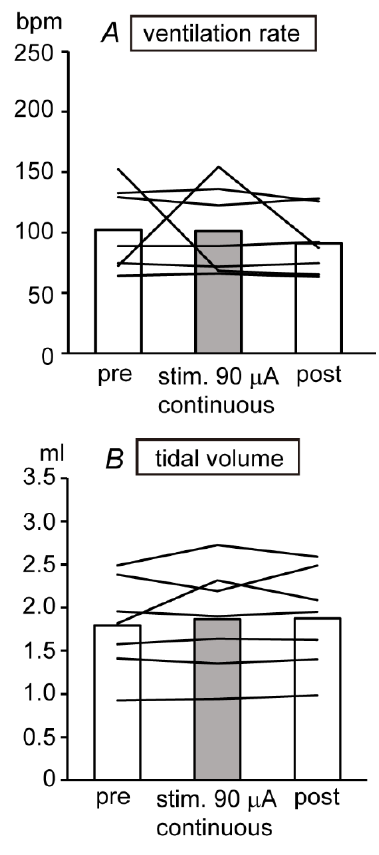
Figure 2. Effect of SLN stimulation (0.5 ms, 90 μA, continuous 40 Hz) on ventilation rate ( A ) and tidal volume ( B ) of conscious rats ( n = 7). The ventilation rate and tidal volume were averaged 30 s or 5 min before, during, and after the stimulation. Each column represents mean value and lines indicate data obtained from individual rat.